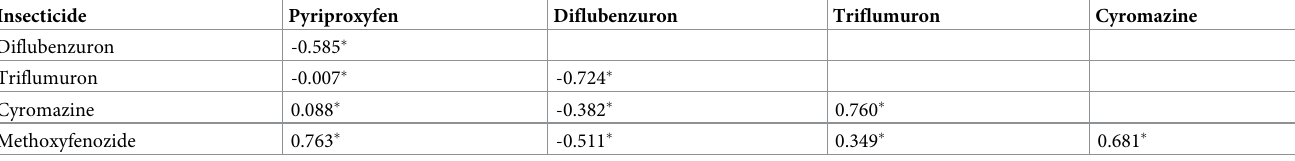
Table 4. Correlation of resistance ratios of insect growth regulators to the house fly populations.